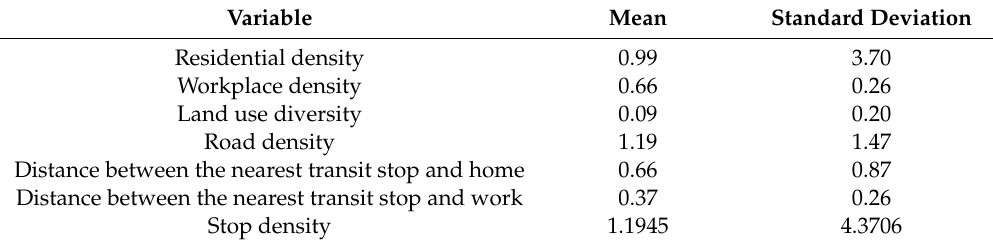
Table 3. Descriptive statistics of built environment